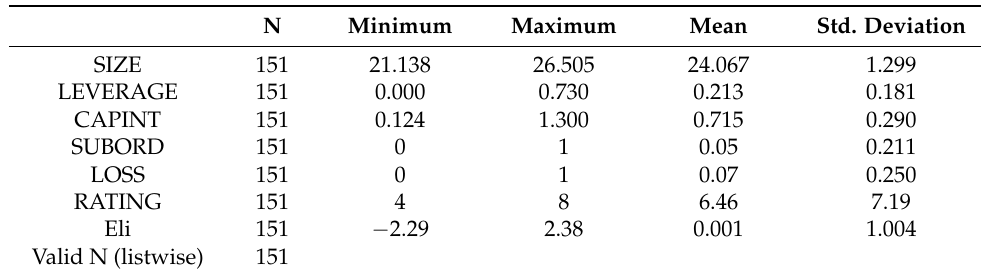
Table 3. Summary of descriptive